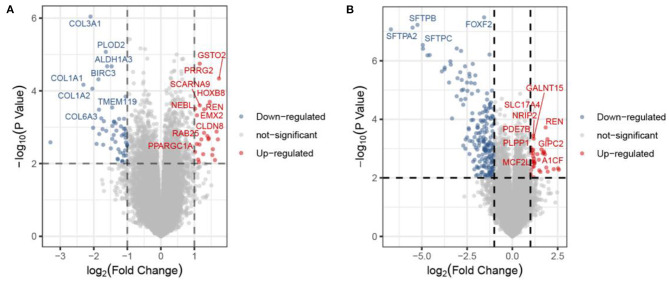
Volcano plot of the DEGs in the primary ccRCC group compared with the metastatic ccRCC group from the GSE105261 (A) and GSE85258 (B) datasets. Each point corresponds to one gene.